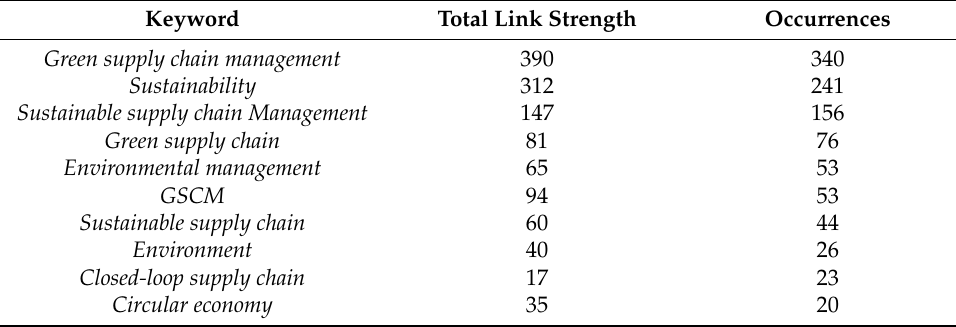
Table 1. The number of keyword occurrences in the entire sample.